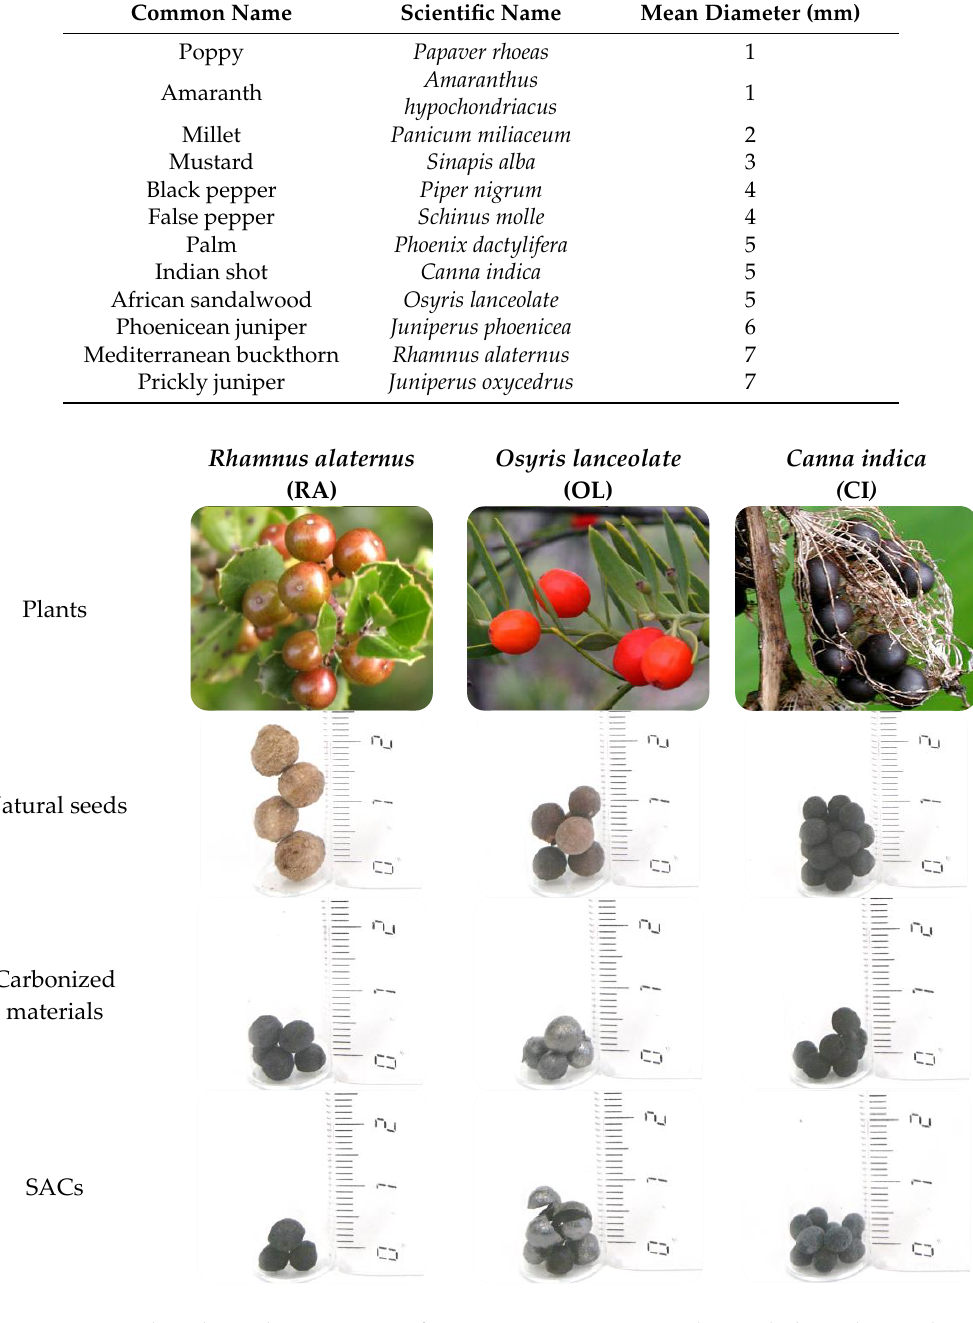
Figure 1. Natural seeds used as precursors for SACs preparation, together with the carbonized and activated spherical materials prepared from them.